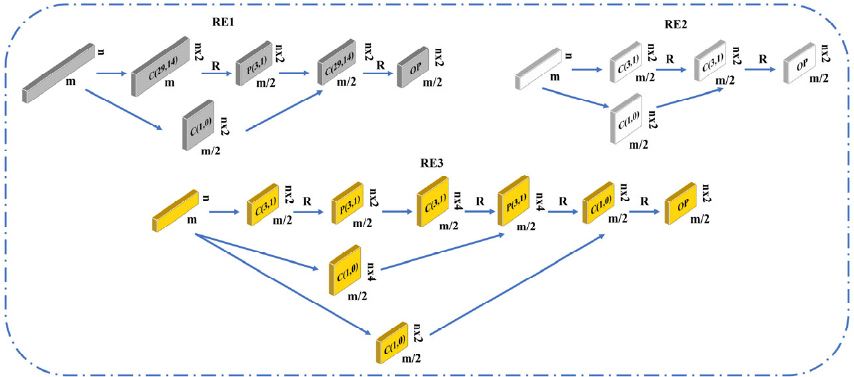
Figure 7. Three kinds of residual blocks in networks.